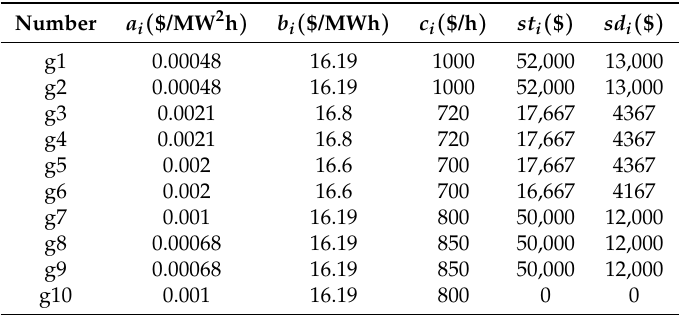
Table 1. Cost coefficients of thermal power units.